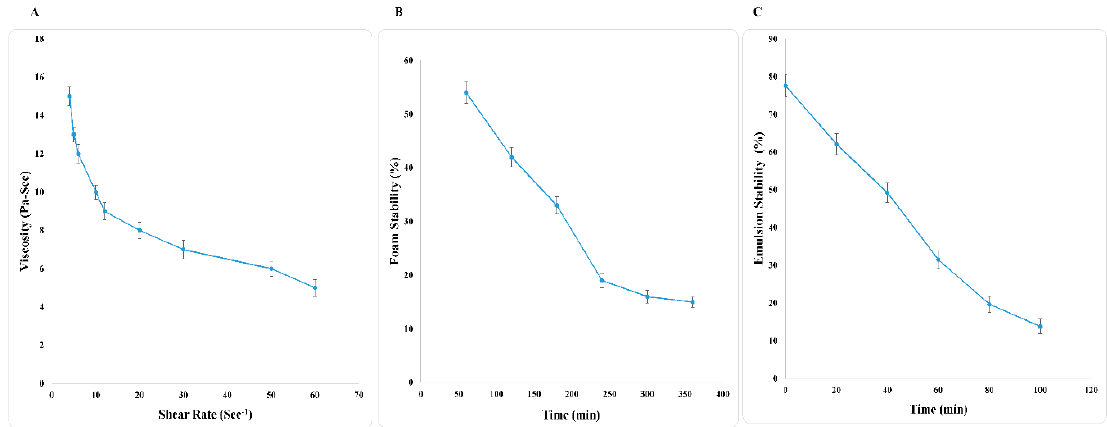
Figure 3. Functional properties of PSG. ( A ) Effect of shear rate on viscosity; ( B ) Effect of time on foam stability and ( C ) Effect of time on emulsion stability.